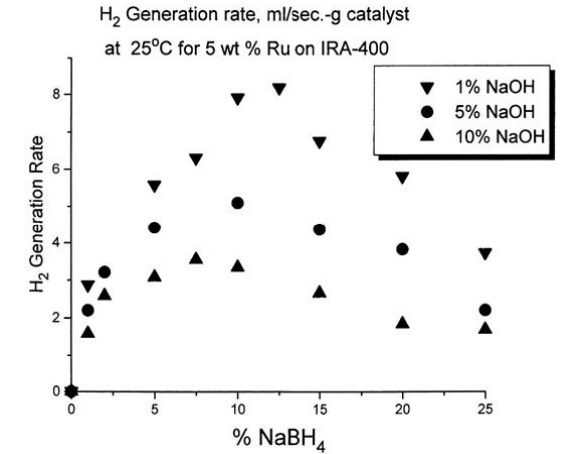
Figure 15. Effect of NaOH on NaBH 4 hydrogen desorption rate.